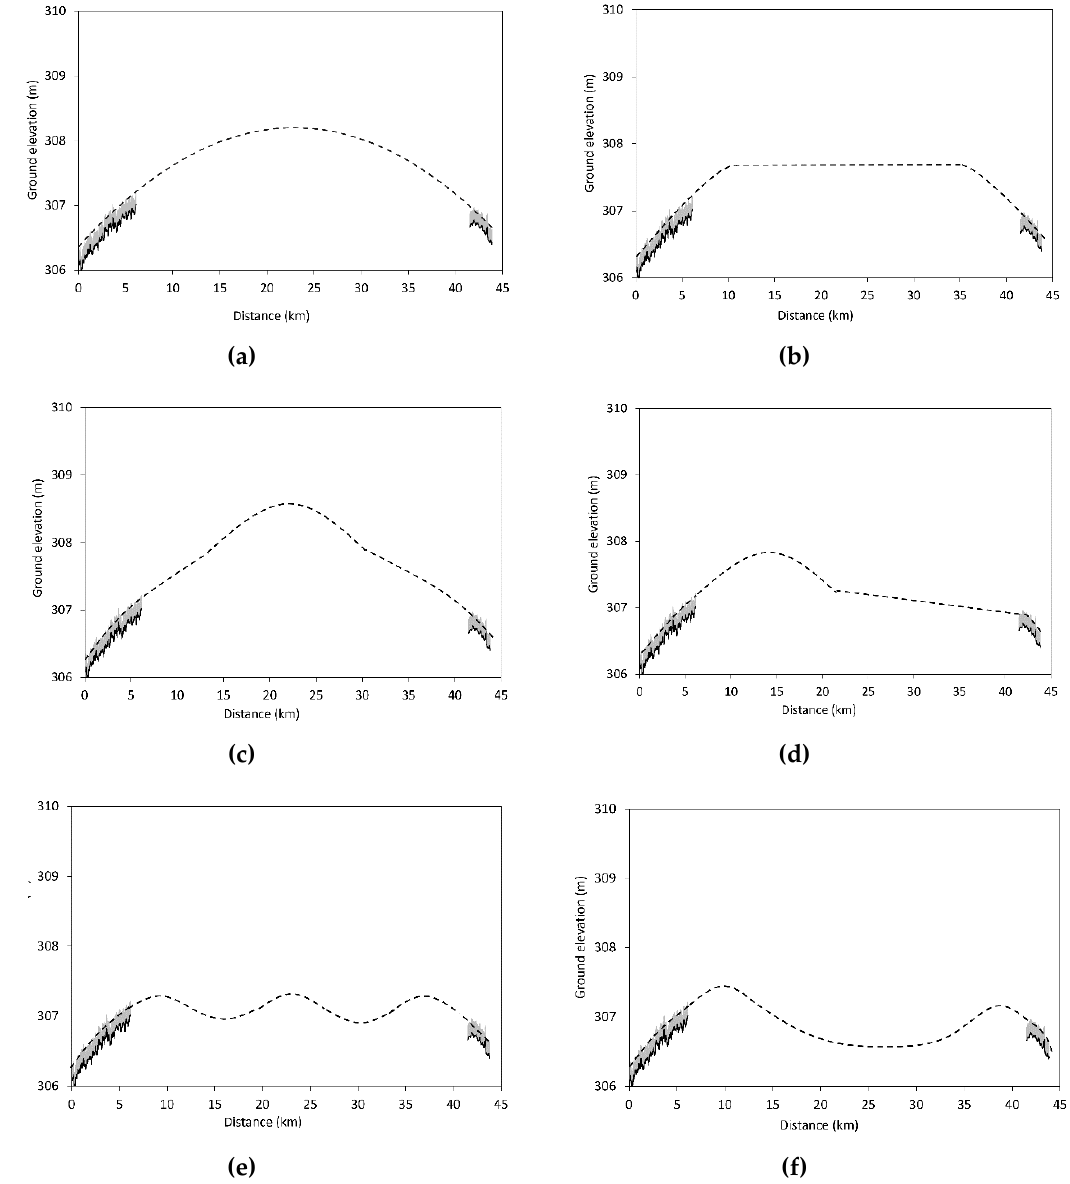
Figure 10. Potential peat dome morphologies: ( a ) convex dome, ( b ) plateau dome, ( c ) stepped dome, ( d ) sloping dome, ( e ) undulating dome, ( f ) double dome with intervening basin.